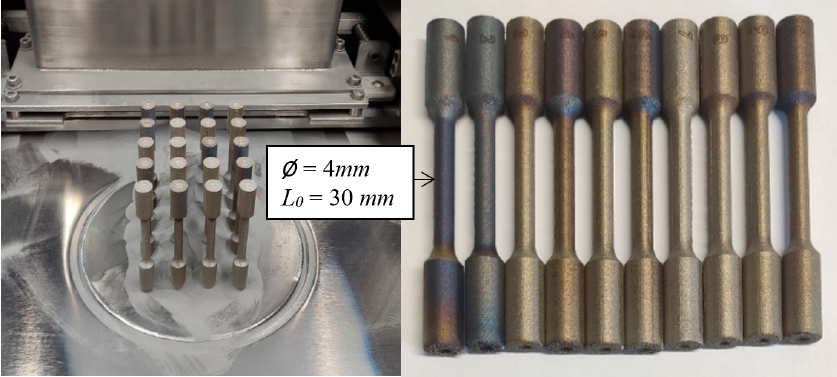
Figure 1. Tensile specimens manufactured using SLM.